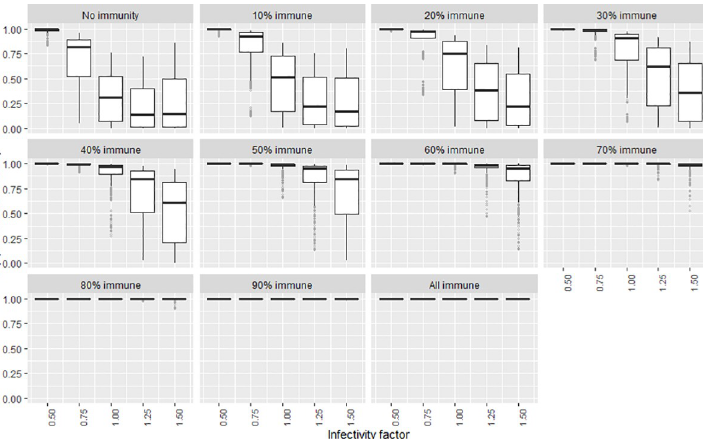
Fig 8. The certainty of the effect of the infectivity factor on P(elim.) at different herd immunities. The range of possible values when other parameters not shown in this plot are varied over their ranges. The boxplot shows the median, the interquartile range, minimums and maximums (1.5 times the 1 st and 3 rd quarter values) and outliers (grey